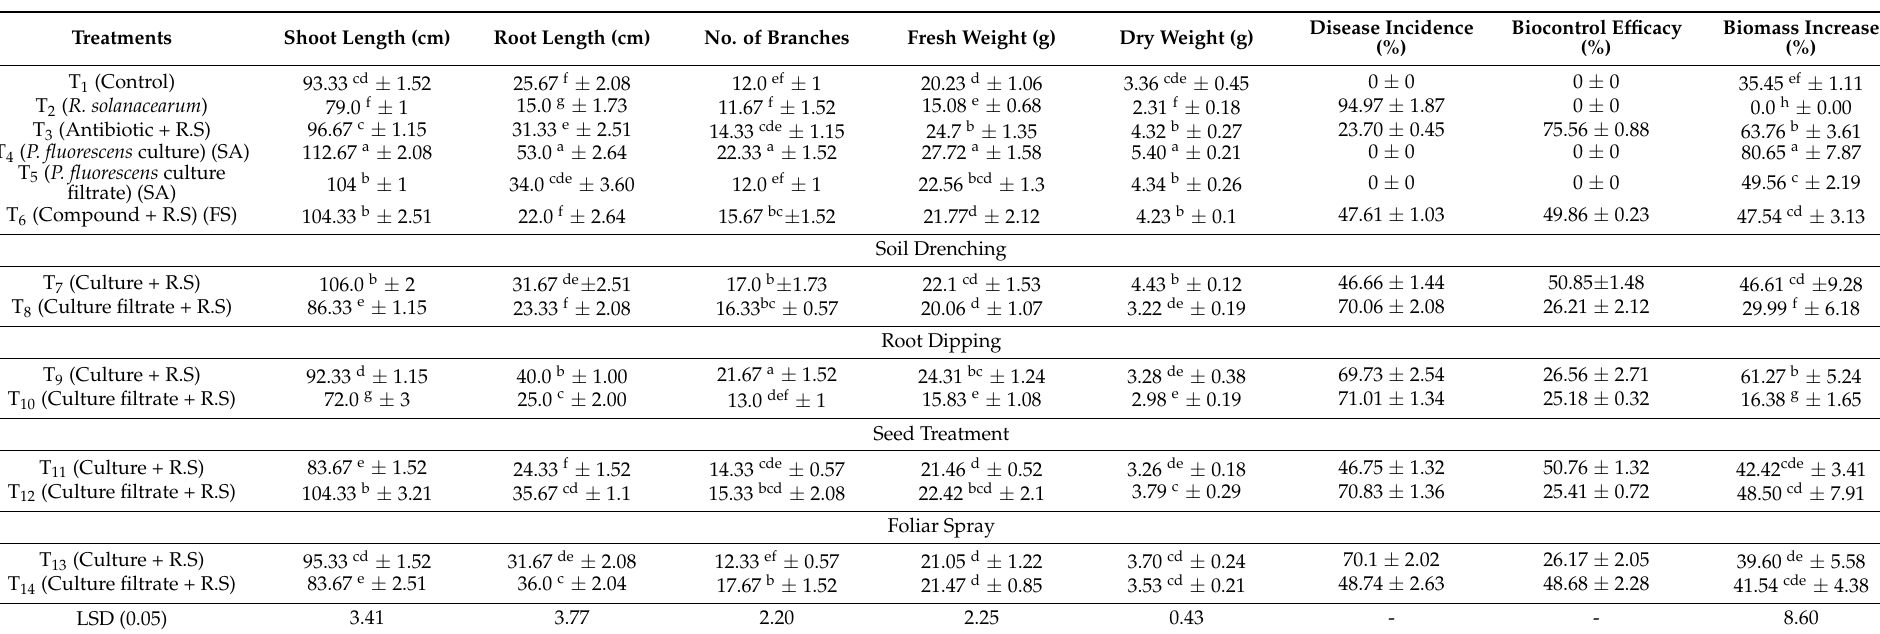
Table 5. Biocontrol efficiency of P. fluorescens VSMKU3054 and 2,4-DAPG against bacterial wilt disease in tomato (PKM1) growth under greenhouse